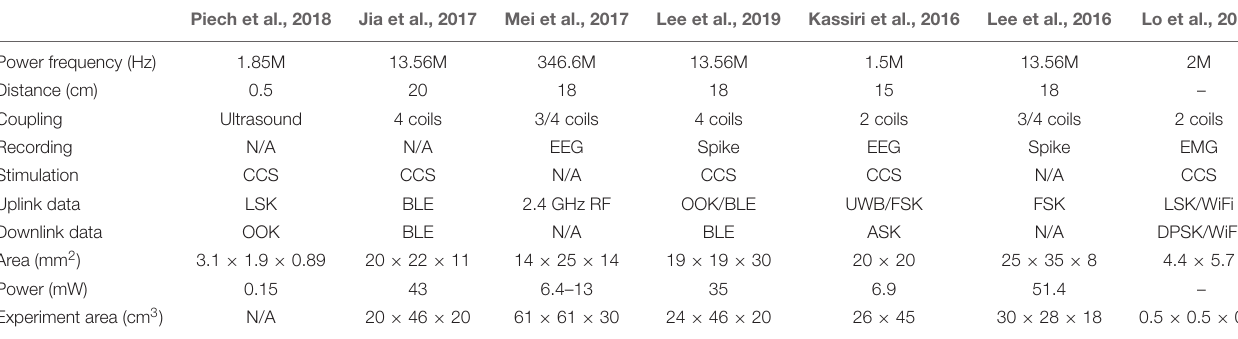
TABLE 4 | Comparison of the parameters of wireless power